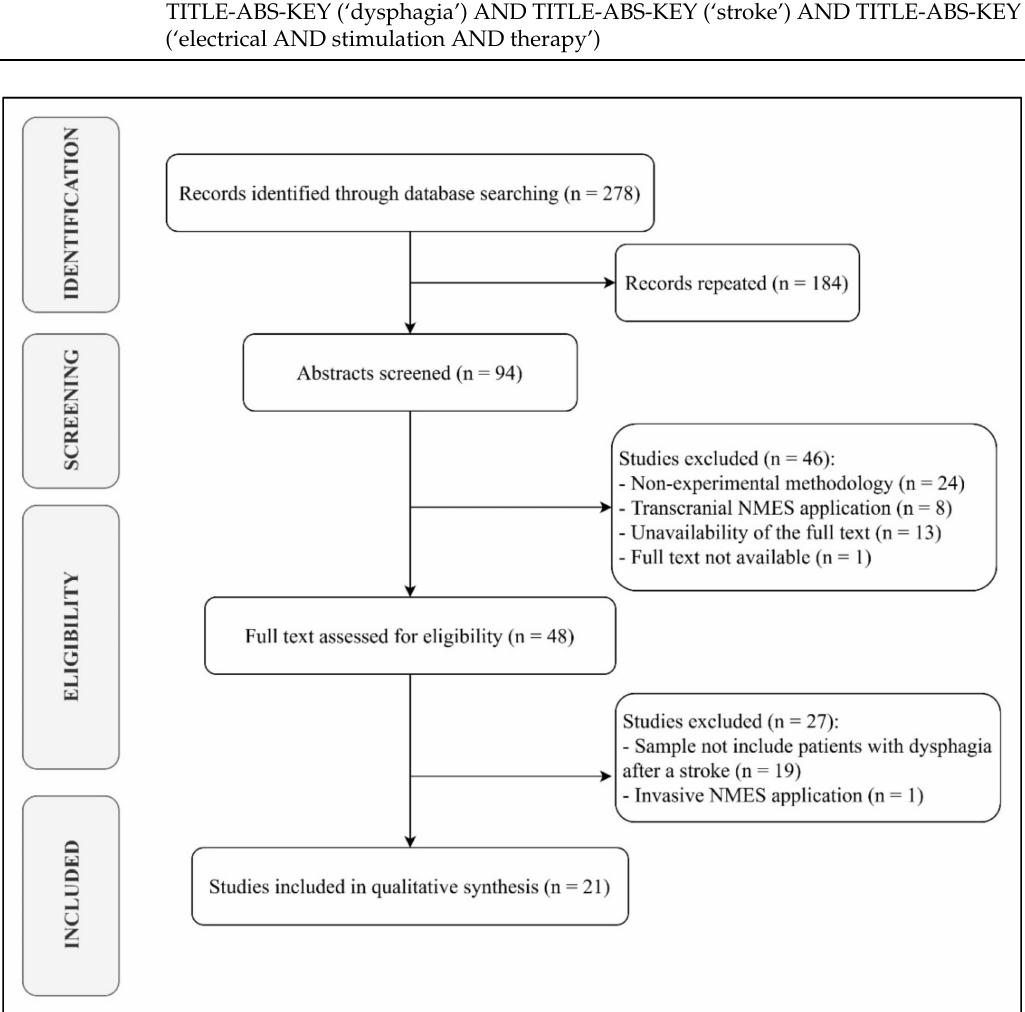
Figure 1. PRISMA chart detailing the article selection